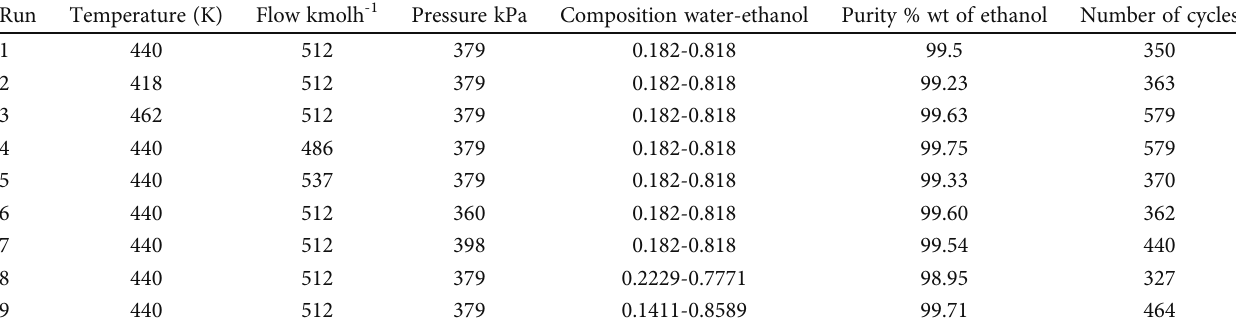
Table 7: Data obtained in the CSS from the parametric